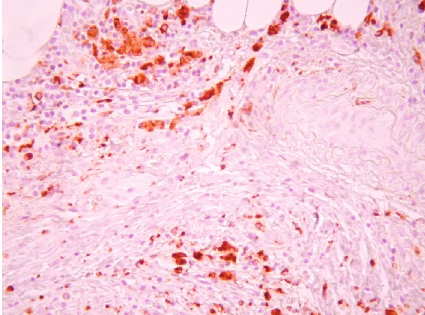
Figure 12: Pancreatic ductal carcinoma, in fl ammatory in fi ltrate, intratumoral and peritumoral (predominant) tissues, immunohistochemical staining, CD 68, ×